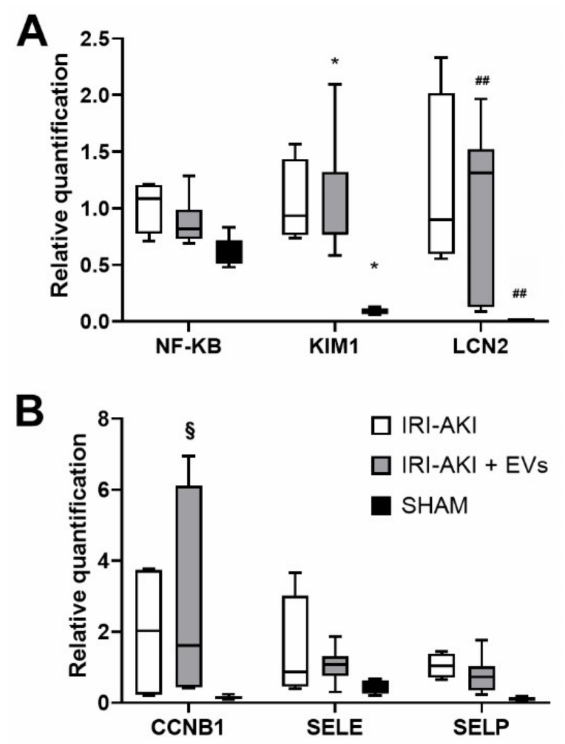
Figure 6. The effect of HLSC-EVs on renal damage in IRI-AKI mice that were sacrificed two days